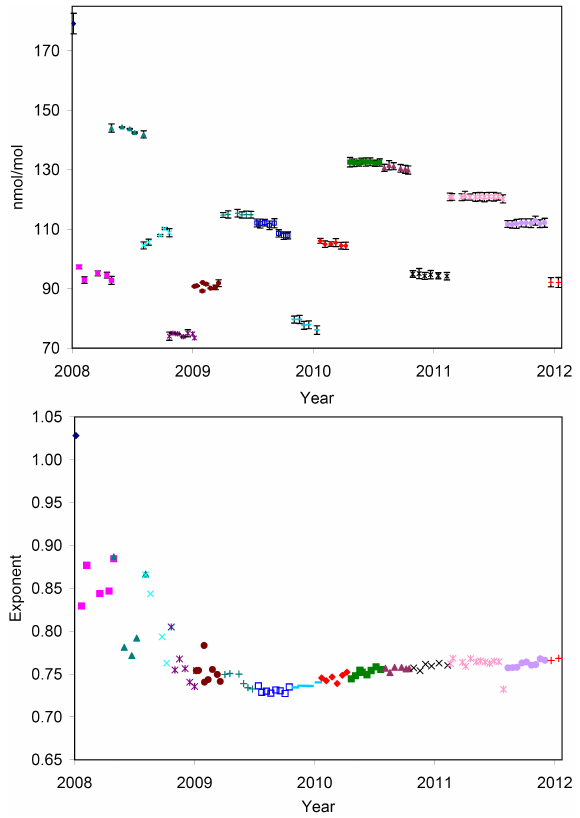
Fig. 3. Upper graph: working gas mole fractions obtained from cal- ibrations conducted during 2008 to 2011. Error bars represent the RMS residual of each calibration, i.e. ± u fit . Lower graph: response function exponents obtained in the calibrations. Different colours and symbols are used for the different working gases.